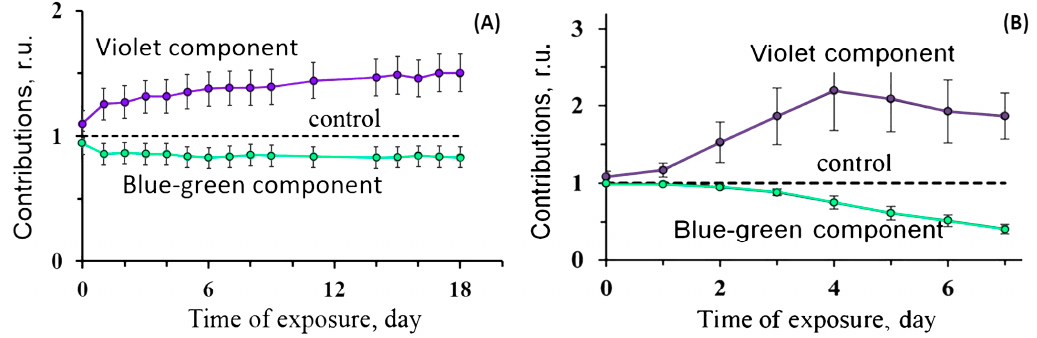
Figure 9. Relative contributions of spectral components to the fluorescence spectra of CLM-containing protein (“discharged obelin” from Obelia longissima) exposed to ( A ) tritiated water, 200 MBq/L [87]; or ( B ) gamma radiation, 137 Cs, 2 mGy/h, 20 ° С . Dependence of the response of CLM-containing protein on the temperature was demonstrated [88] for low-intensity gamma radiation, as well.